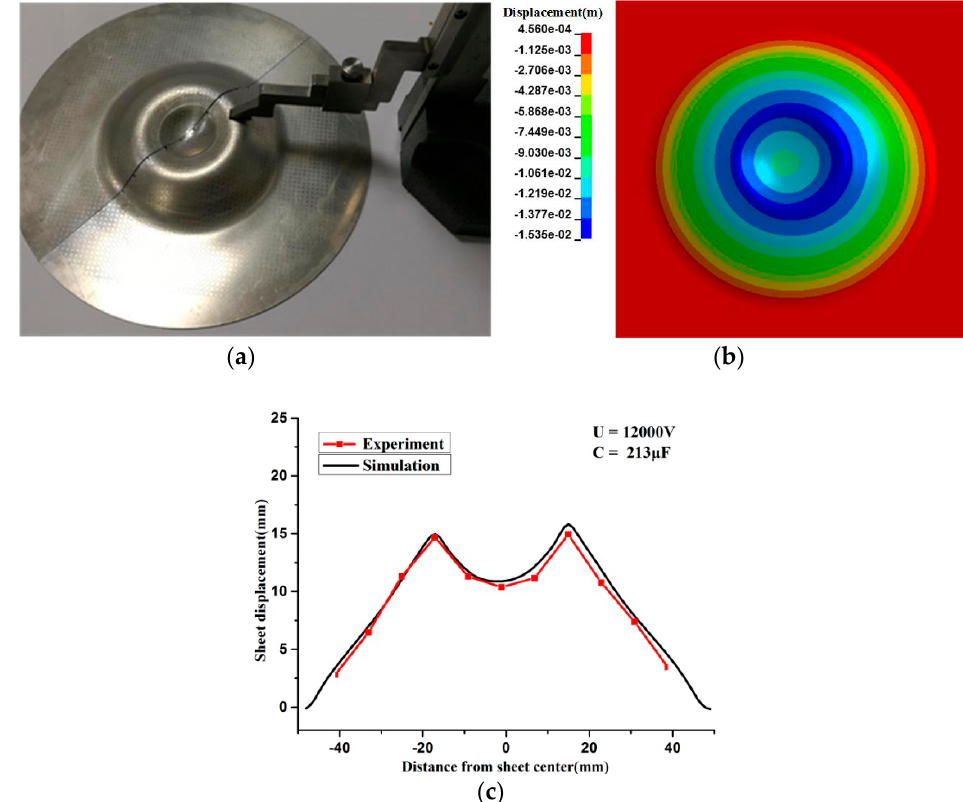
Figure 17. Deformation height and shape profiles of high-speed impaction at a discharge voltage of 12 kV: ( a ) experimental result; ( b ) simulation result; and ( c ) profiles comparison between the experimental and simulated results along the central plane.